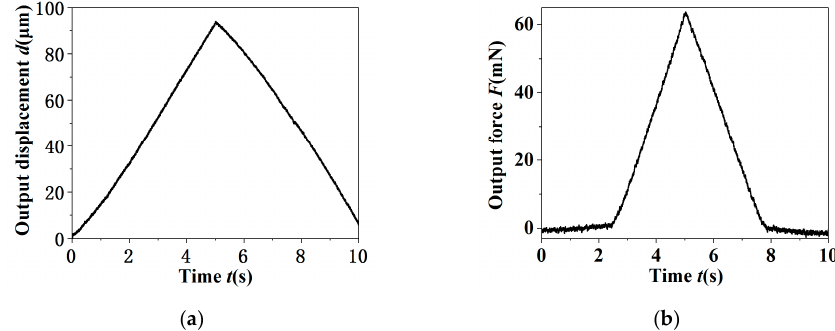
Figure 13. The actual gripping process. ( a ) The tip displacement; ( b ) the gripping force.